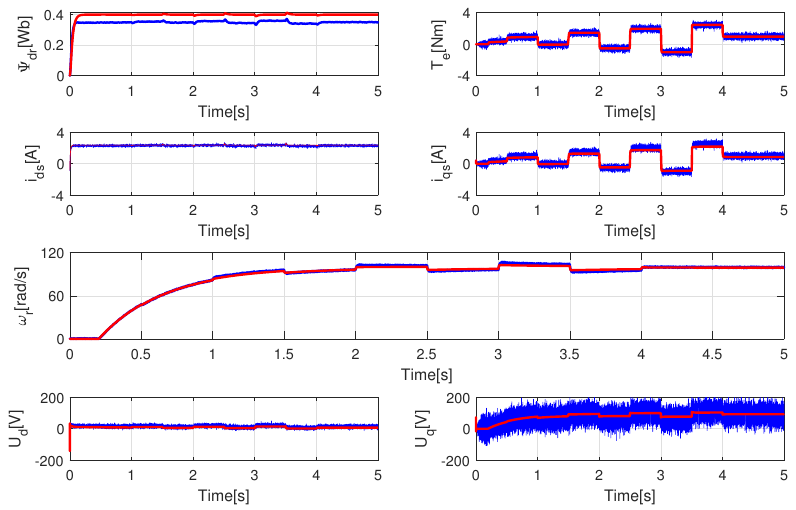
Figure 12. Case 3, parameter uncertainty test compared to ideal condition. Red curves with nominal parameters, blue ones with tuned.